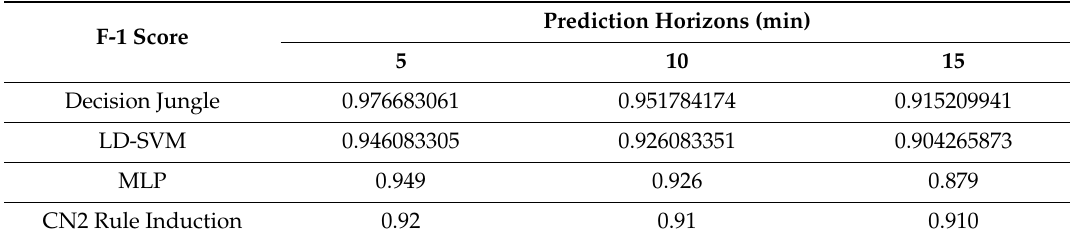
Table 4. F-1 score for the di ff erent model comparisons.